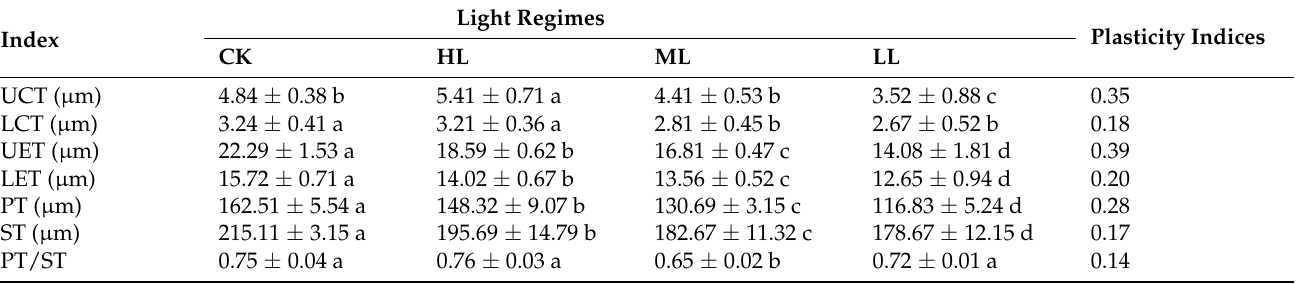
Table 2. Anatomical characteristic parameters of C. oleifera leaves under different light